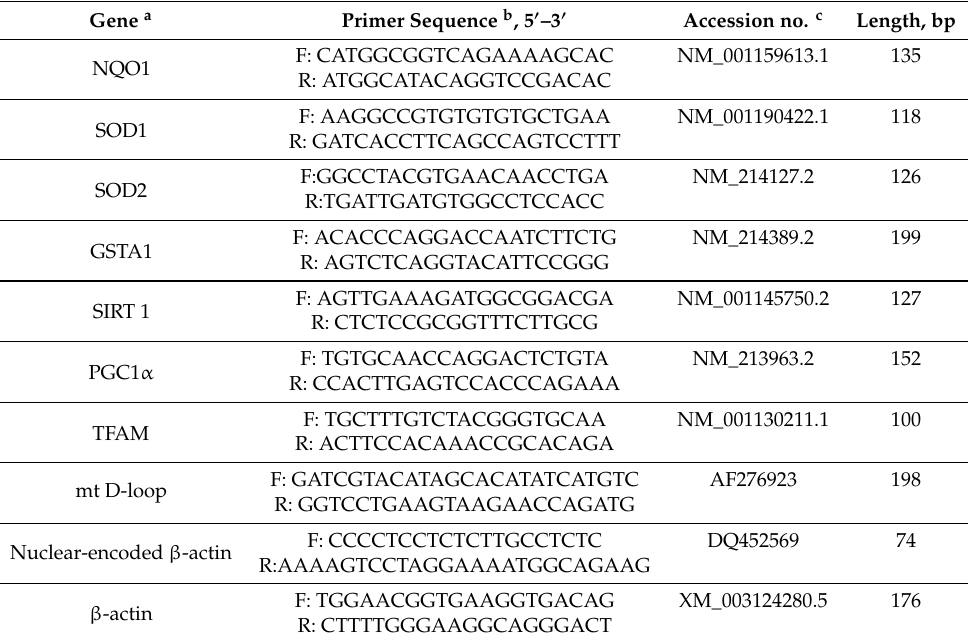
Table 2. Primer sequence used in this